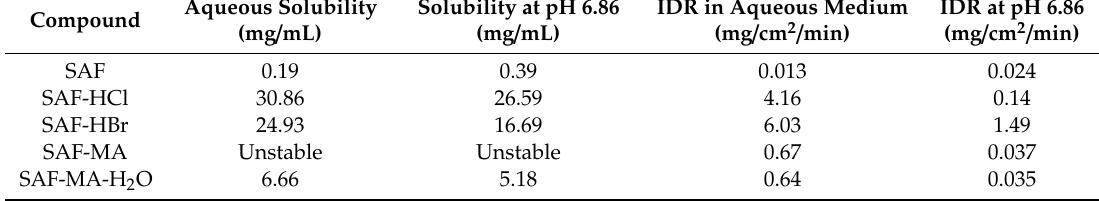
Table 3. Solubility and intrinsic dissolution rate (IDR) of safinamide and its new salts in water and pH 6.86. Compound